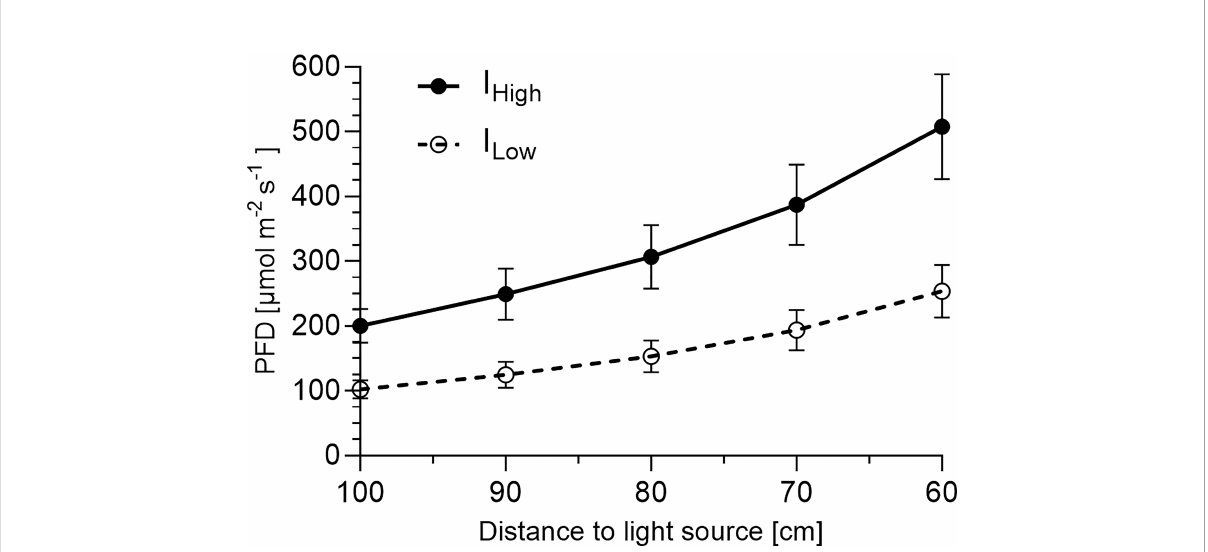
FIGURE 3 Photon fl ux density depending on distance to light source 1. 1 Presented are average photon fl ux densities ( PFD ) [µmol m -2 s -1 ] ± SD between 400 and 780 nm recorded in 10 cm intervals (starting at cultivation table level 100 cm from the light source) from nine representative positions across the cultivation area (1.2 m 2 ) at each distance.